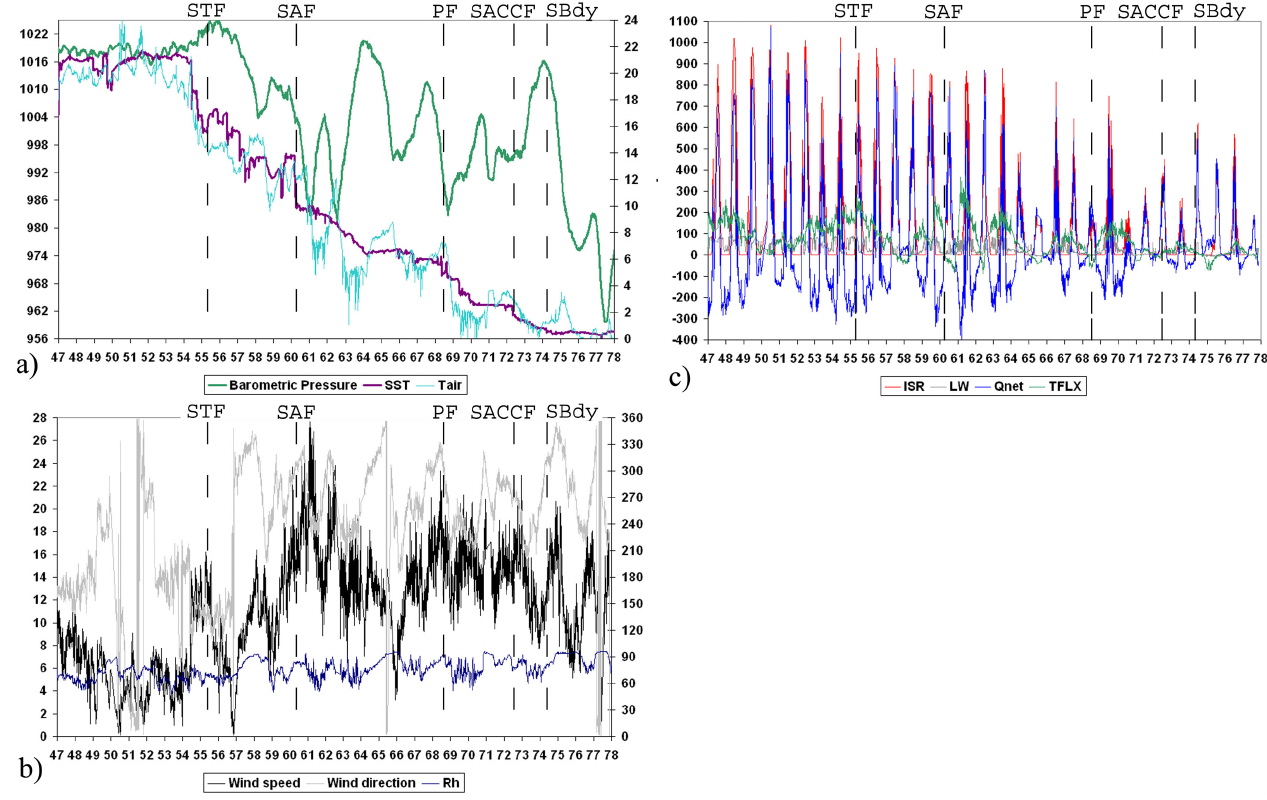
Fig. 2. Time series of: (a) the barometric pressure in hPa (green line), the SST and air temperature at ten meters height in ◦ C (purple and blue lines respectively); (b) wind speed in ms − 1 and wind direction (black and grey lines respectively) as well as relative humidity (dark blue line) in %; (c) turbulent heat fluxes (green curve) – positive upward, incoming solar radiation (red curve) – positive downward, longwave radiation (gray curve) – positive upward, net heat flux (dark blue curve) – negative upward. For (a) , left vertical axis is pressure in hPa and right vertical scale is temperature in ◦ C. For (b) , left vertical axis is wind speed in ms − 1 and right vertical axe is direction in degree as well as relative humidity in %. For (c) , vertical axis is heat flux in Wm − 2 . For all the frames, the horizontal axis is the day number after the 1 January 2008. The vertical dashed black lines are the location of the oceanic